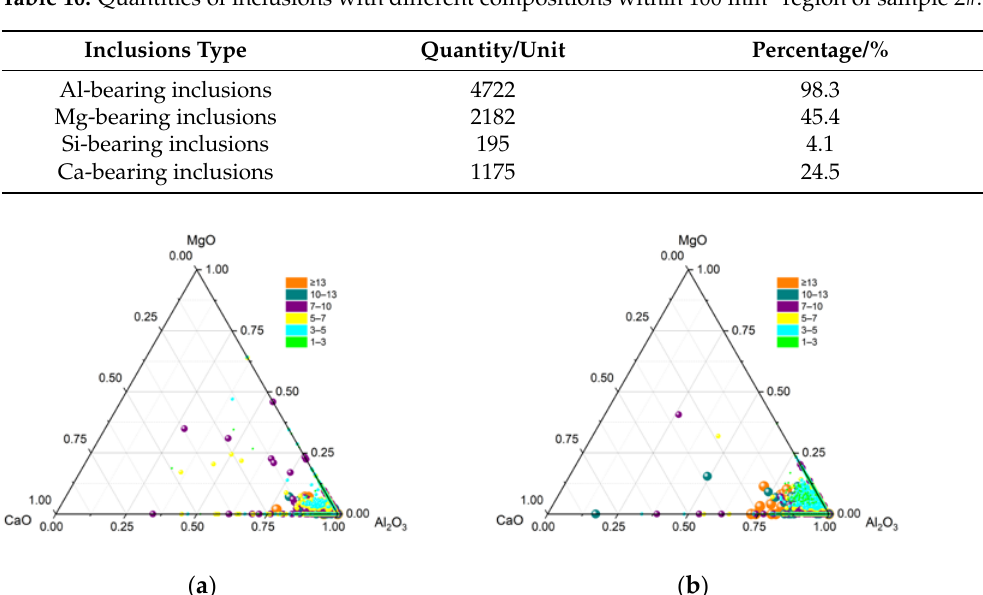
Table 10. Quantities of inclusions with different compositions within 100 mm 2 region of sample 2#.